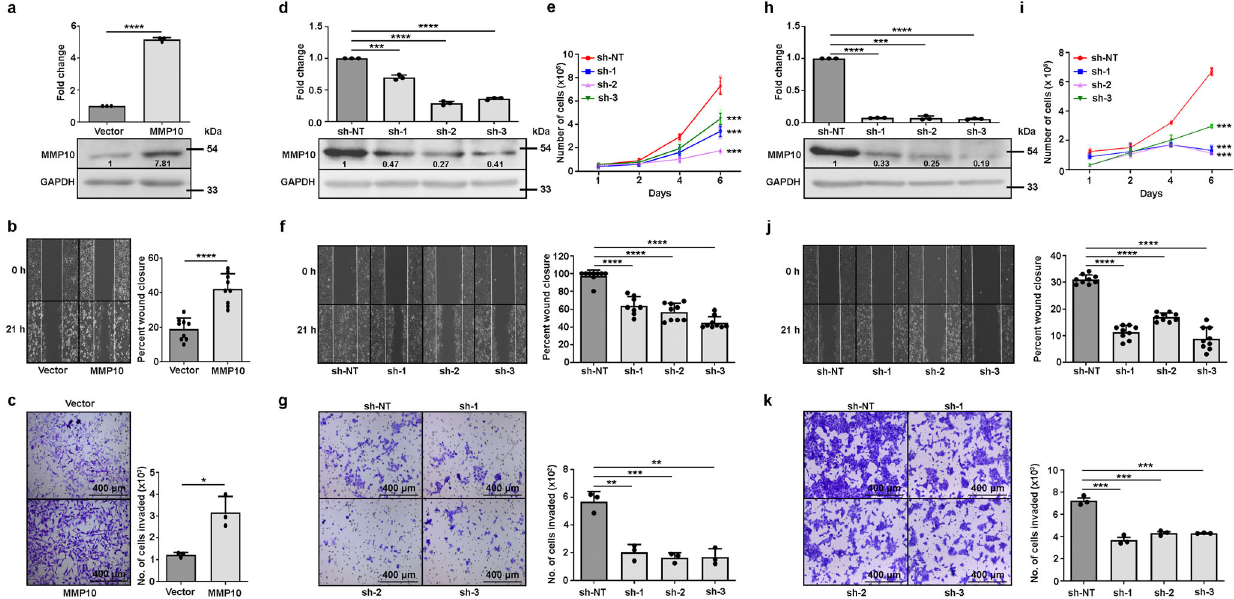
Fig. 2 Genetic perturbation of MMP10 affects cell proliferation, migration and invasion of tongue cancer cells. a qRT-PCR and immunoblot of MMP10 and GAPDH in AW13516 cells stably overexpressing empty vector or MMP10 . Numbers on the blot indicate intensity ratio of MMP10 expression with respect to the vector control lane. b , f , j Wound-healing assay of AW13516 cells stably overexpressing empty vector or MMP10 ( b ), AW8507 cells ( f ) and CAL27 cells ( j ) with non-targeting shRNA (sh-NT) or stable MMP10 knockdown (3 shRNAs – sh1 or sh-2 or sh-3). Representative images of wound-healing assay at 0 h and 21 h are presented along with the bar plots indicating the percentage of wound closure. c , g , k Boyden chamber matrigel invasion assay of AW13516 cells stably overexpressing empty vector or MMP10 ( c ), AW8507 cells ( g ) and CAL27 cells ( k ) with sh-NT or stable MMP10 knockdown with sh1 or sh-2 or sh-3. Representative images of crystal violet stained Boyden chamber along with the bar plots depict the percent cell invasion (scale bar = 400 µ m). d , h qRT-PCR and immunoblot of MMP10 and GAPDH in AW8507 ( d ) and CAL27 (h) cells with sh-NT or stable MMP10 knockdown. Numbers on the blot indicate intensity ratio of MMP10 expression with respect to the sh-NT control lane. e , i Cell proliferation assay of AW8507 ( e ) and CAL27 cells ( i ) with sh-NT or stable MMP10 knockdown with sh-1 or sh-2 or sh-3. Scatter plots indicate the number of live cells on the mentioned day. Data are shown as means± SD. p -values are from Student ’ s unpaired t -test and denoted as * p < 0.05; ** p < 0.01; *** p < 0.001; **** p < 0.0001. Data shown are representative of n = 3 independent